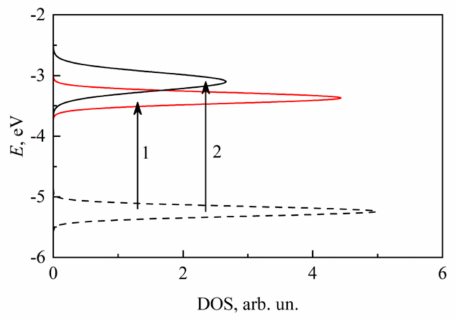
Figure 4. Schematic representation of the density distribution of electron energy states for molecular orbitals of PPQ–DBT fragments. Dashed black line is the HOMO DBT, solid black line–the LUMO DBT, solid red line–LUMO